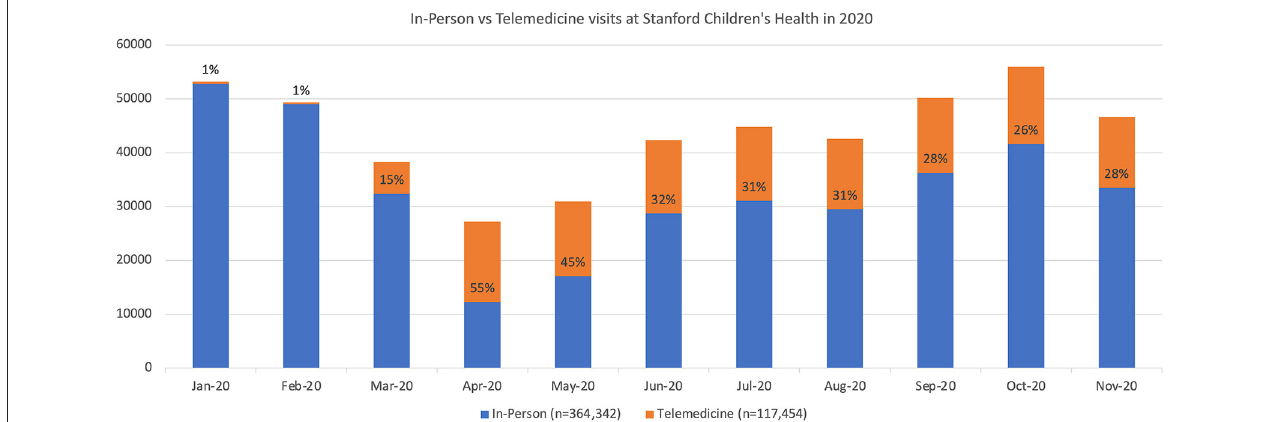
FIGURE 1 | Percentage of In-person vs. TM visits at Stanford Children’s Health in 2020.